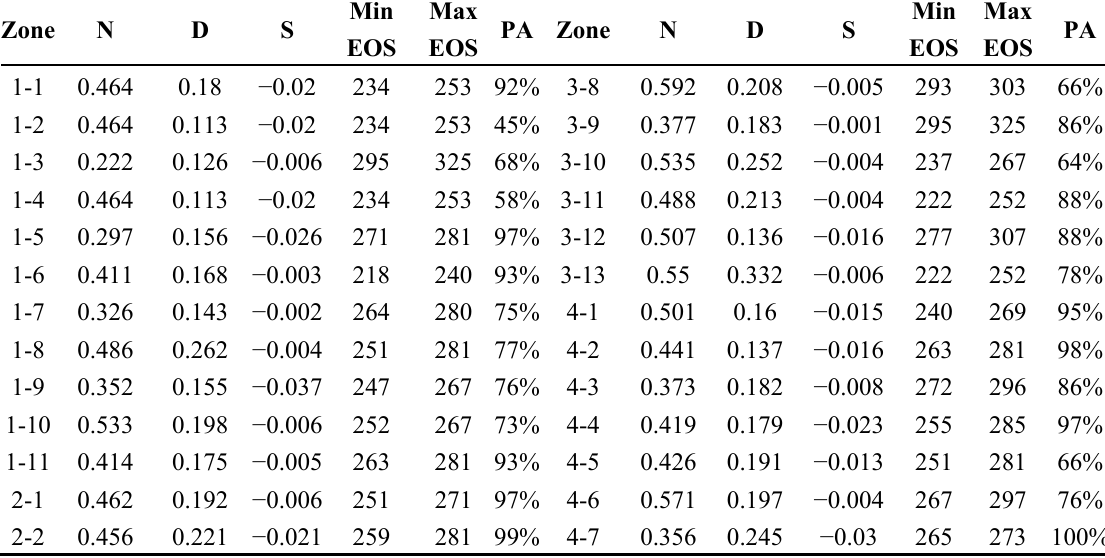
Table 2 . Groups of detection thresholds for EOS, MinEOS (DOY), MaxEOS (DOY), and percentage of accepted pixels (PA) for each zone. N = NDVI; D = difference; S =